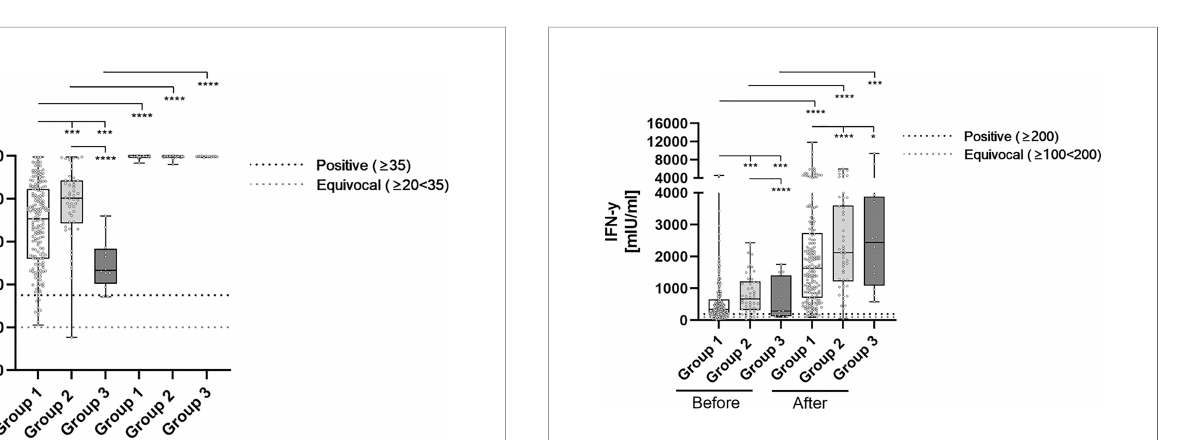
FIGURE 4 | Comparative determinationofSARS-CoV-2 speci fi c t-cellresponse beforeandafterthirdbooster vaccinationwithBNT162b2. Toevaluatedifferences betweenvaccination-strategies, participants weregroupedinto3 cohorts:Group1: threevaccine-dosesofBNT162b2; Group2:initiallytwovaccine-dosesof ChAdOx1andBNT162b2 booster-dosage; Group3:heterologousvaccination- protocol(ChAdOx1+ BNT162b2)andBNT162b2booster-dosage.Cellular immunitytoSARS-CoV-2was assessedbyusing anInterferon(IFN)-gamma releaseassay(IGRA) fromEuroimmun(Quan-T-cellSARS-CoV-2kit).Values ≥ 200 mIU/mlwereconsideredpositive(horizontalblackdottedline),whereasvalues between100-200mIU/mlwere consideredequivocal(horizontalgraydottedline). *p< 0.05;***p<0.001; ****p<0.0001